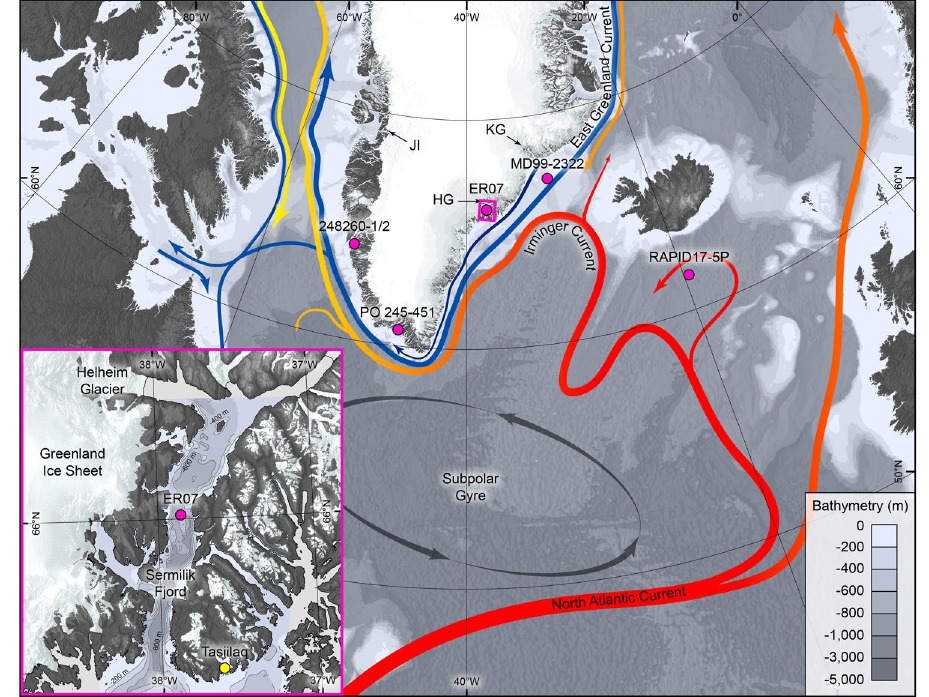
Figure 1. Map of the North Atlantic region showing the major surface ocean currents 13 (colour of arrows indicate temperature; red = warm, blue = cold, yellow = mixture) and location of sites referred to in Fig. 3a–f. HG = Helheim Glacier; KG = Kangerdlugssuaq Glacier; JI = Jakobshavn Isbræ. Magenta circles show location of sediment cores discussed in the text and shown on Figs 2 and 3. The magenta box delineates the extent of the inset map. Bathymetric data are from IBCAO v3 56 . Terrestrial topographic data are from the ETOPO1 Global Relief model 57 and the GIMP surface digital elevation model 58 . The inset map of Sermilik Fjord shows the location of sediment core ER07 and the local bathymetry 59 . The figure was created using ArcMap 10 .1 (http:// desktop.arcgis.com/en/arcmap/) and Adobe Illustrator CS6 (